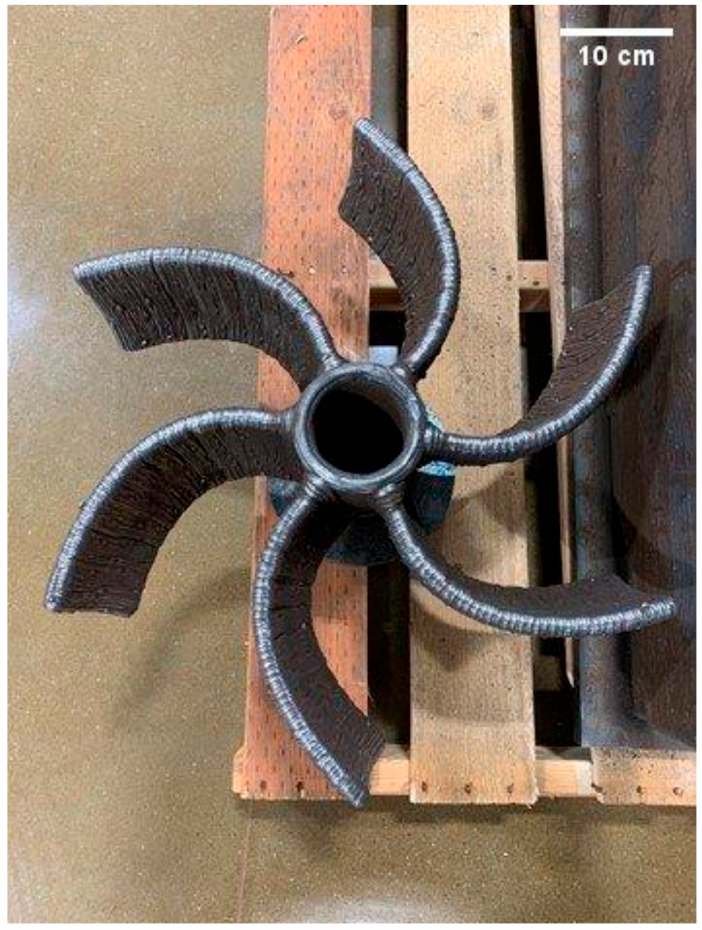
Figure 1. Wire arc manufactured propeller demonstrator at Oak Ridge National Lab Manufacturing Demonstration Facility. The propeller was printed in 20 h and weighed around 60